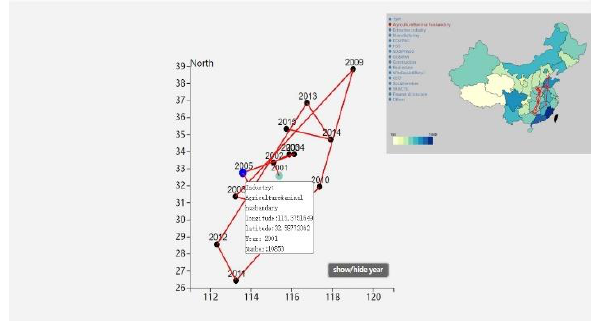
Figure 5. An example of the line chart view that expended to full screen mode